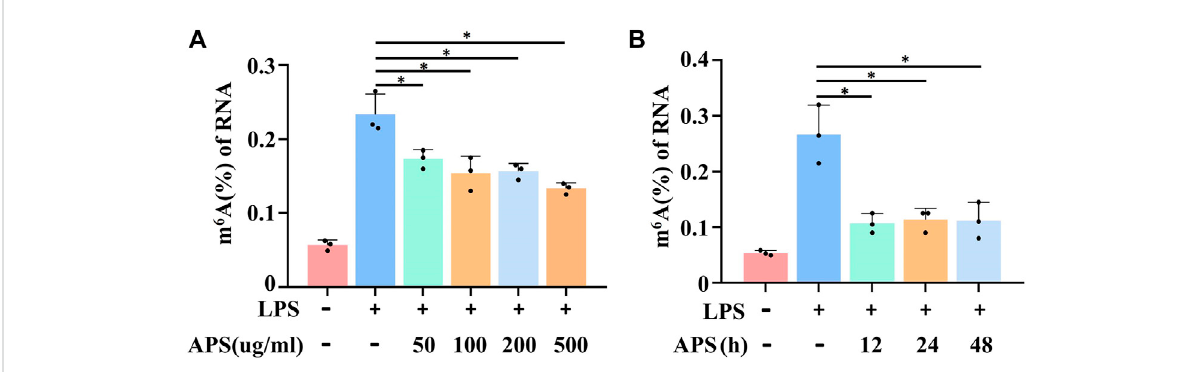
FIGURE 2 APS abrogated LPS-induced m 6 A level in THP-1 macrophages. (A) THP-1 macrophages were treated with APS (50, 100, 200, 500 μ g/ml) for 24 h and then induced with LPS (10 μ g/ml) for 4 h m 6 A level was detected in the cells by m 6 A RNA methylation quanti fi cation. (B) THP-1 macrophages were treated with APS (500 μ g/ml) for different time (0, 12, 24, 48 h) and then induced with LPS (10 μ g/ml) for 4 h. m 6 A level was detected in the cells by m 6 A RNA methylation quanti fi cation. * p < 0.05 compared with LPS group. Data represent the mean ± SEM. n = 3 per